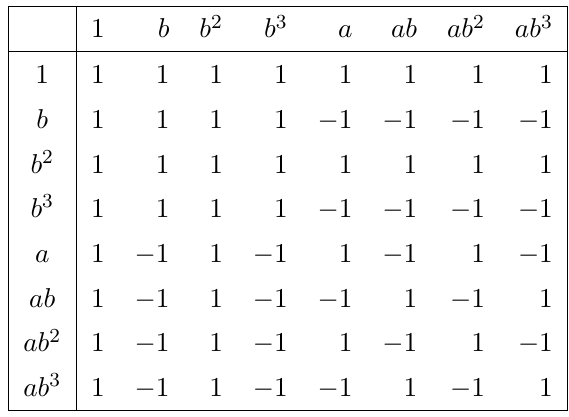
Table 6 . Table of values of (cid:15) ( g, h ) = ω ( g, h ) /ω ( h, g ) for a cocycle representing the nontrivial element of H 2 ( Z Z U(1)) 2 × 4 ,